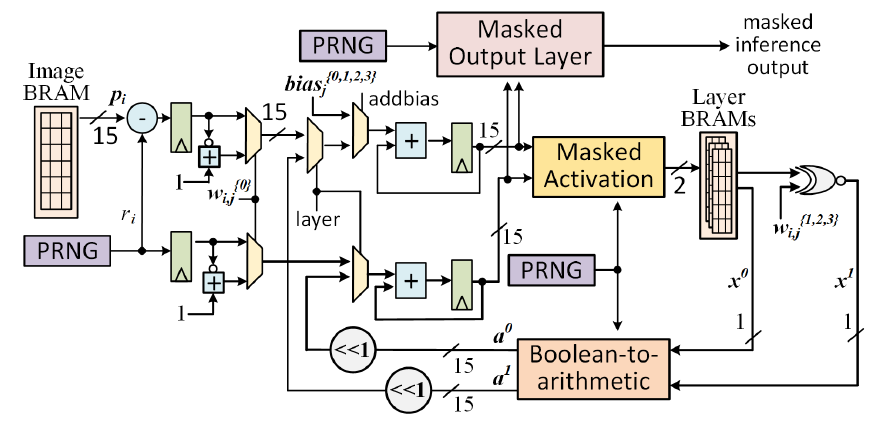
Figure 8: Hardware design of the fully masked ModuloNET inference showing various top-level masked components. The weights w { k } block RAMs. Figure is not to